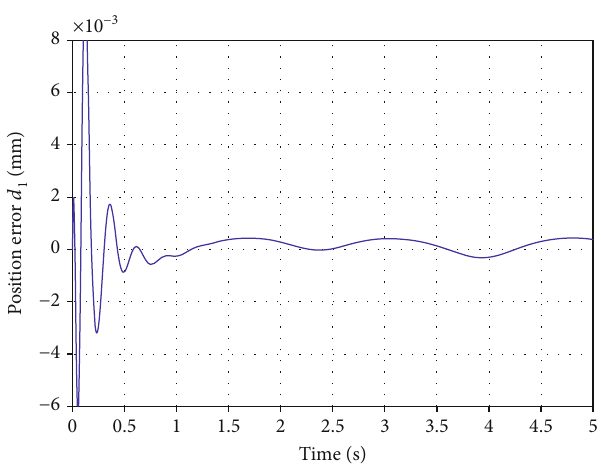
Figure 6: The position error of the fi rst actuated joint d